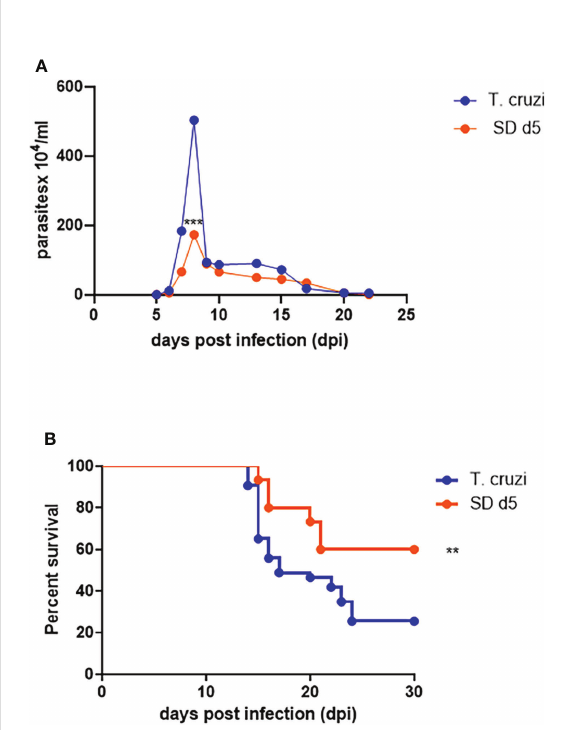
FIGURE 2 1D11 best dose administration in a single dose scheme at 5 dpi reduced the peak of parasitemia and improved the survival rates. The treatment reduced (A) the peak of parasitemia and (B) mortality rates after 30 dpi. Data are means ± standard deviations from three independent experiments. Signi fi cant differences between infected mice treated or not with 1D11 are indicated by **p< 0.01, ***p<